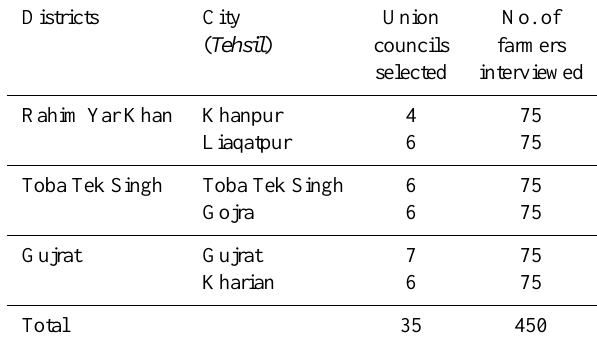
Table 1. The study